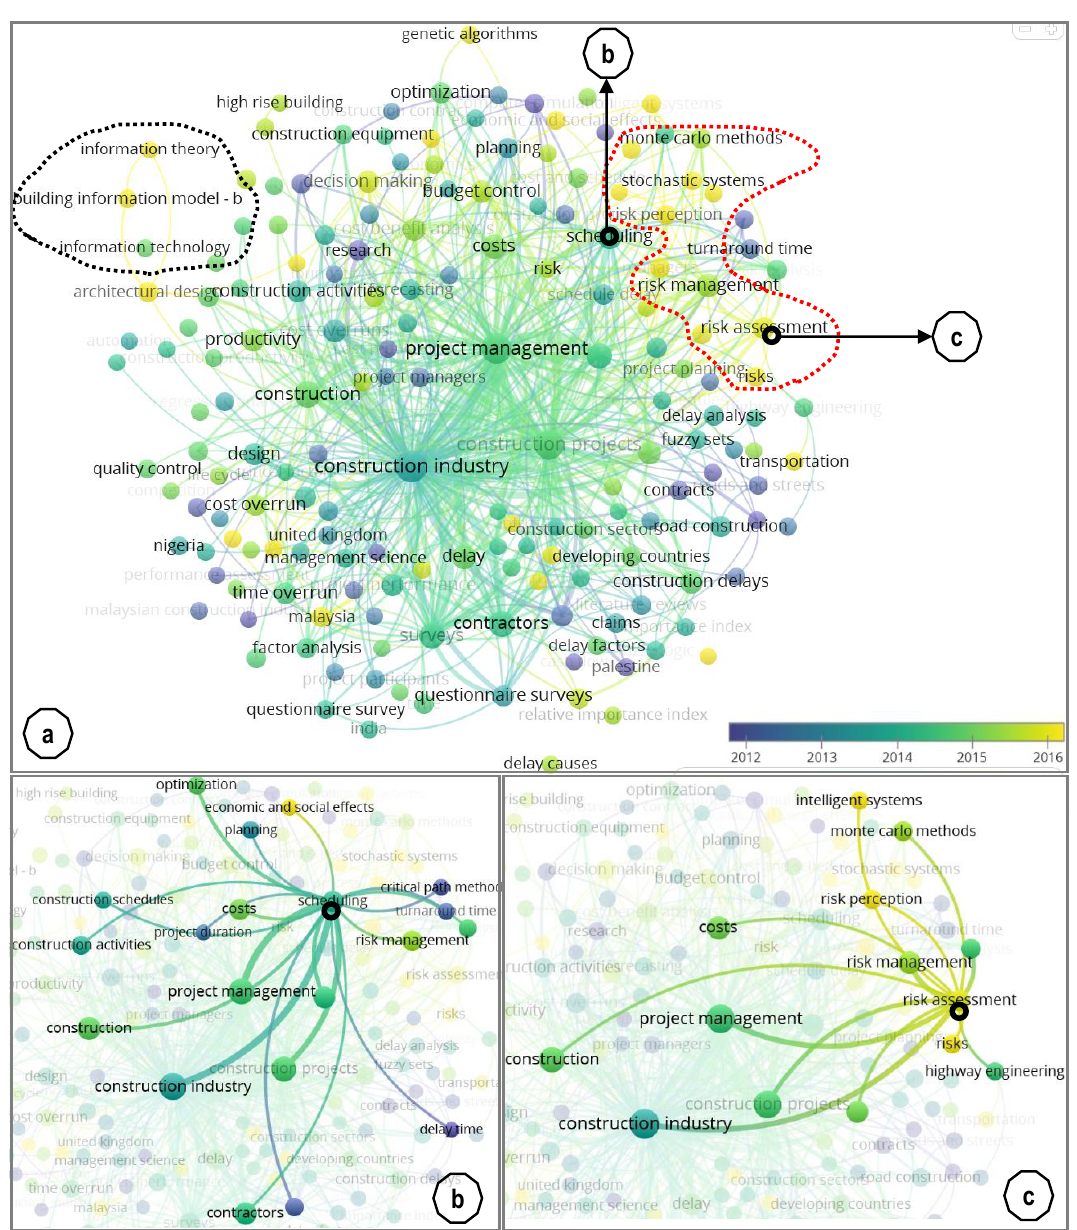
Figure 4. Co-occurrence analytical map of keywords created in the first dataset. With the minimum number of co-occurrence set as five, a total of 176 keywords out of the sample of 2926 keywords are shown. ( a ) All keywords co-occurrence network map; ( b ) scheduling co-occurrence network map; ( c ) risk assessment co-occurrence network map.